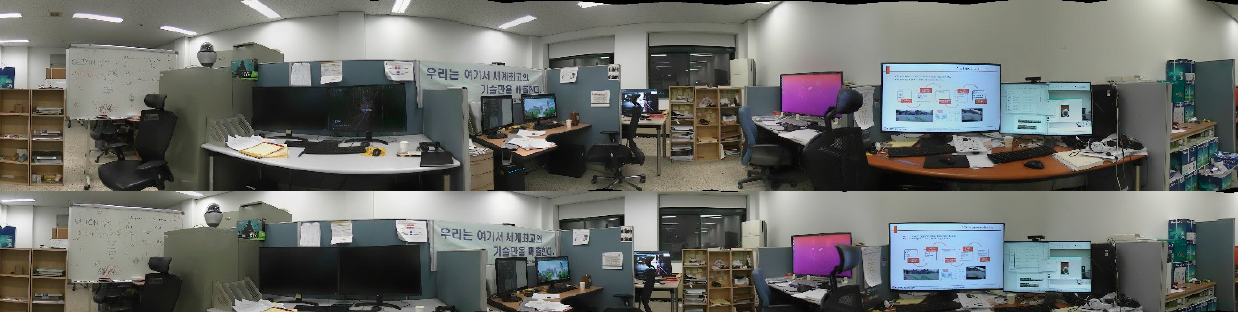
Figure 12. Panoramas from center: upper (10,400 × 1600 = 360° × 56°) and lower (10,400 × 1000 = 360° × 36°).